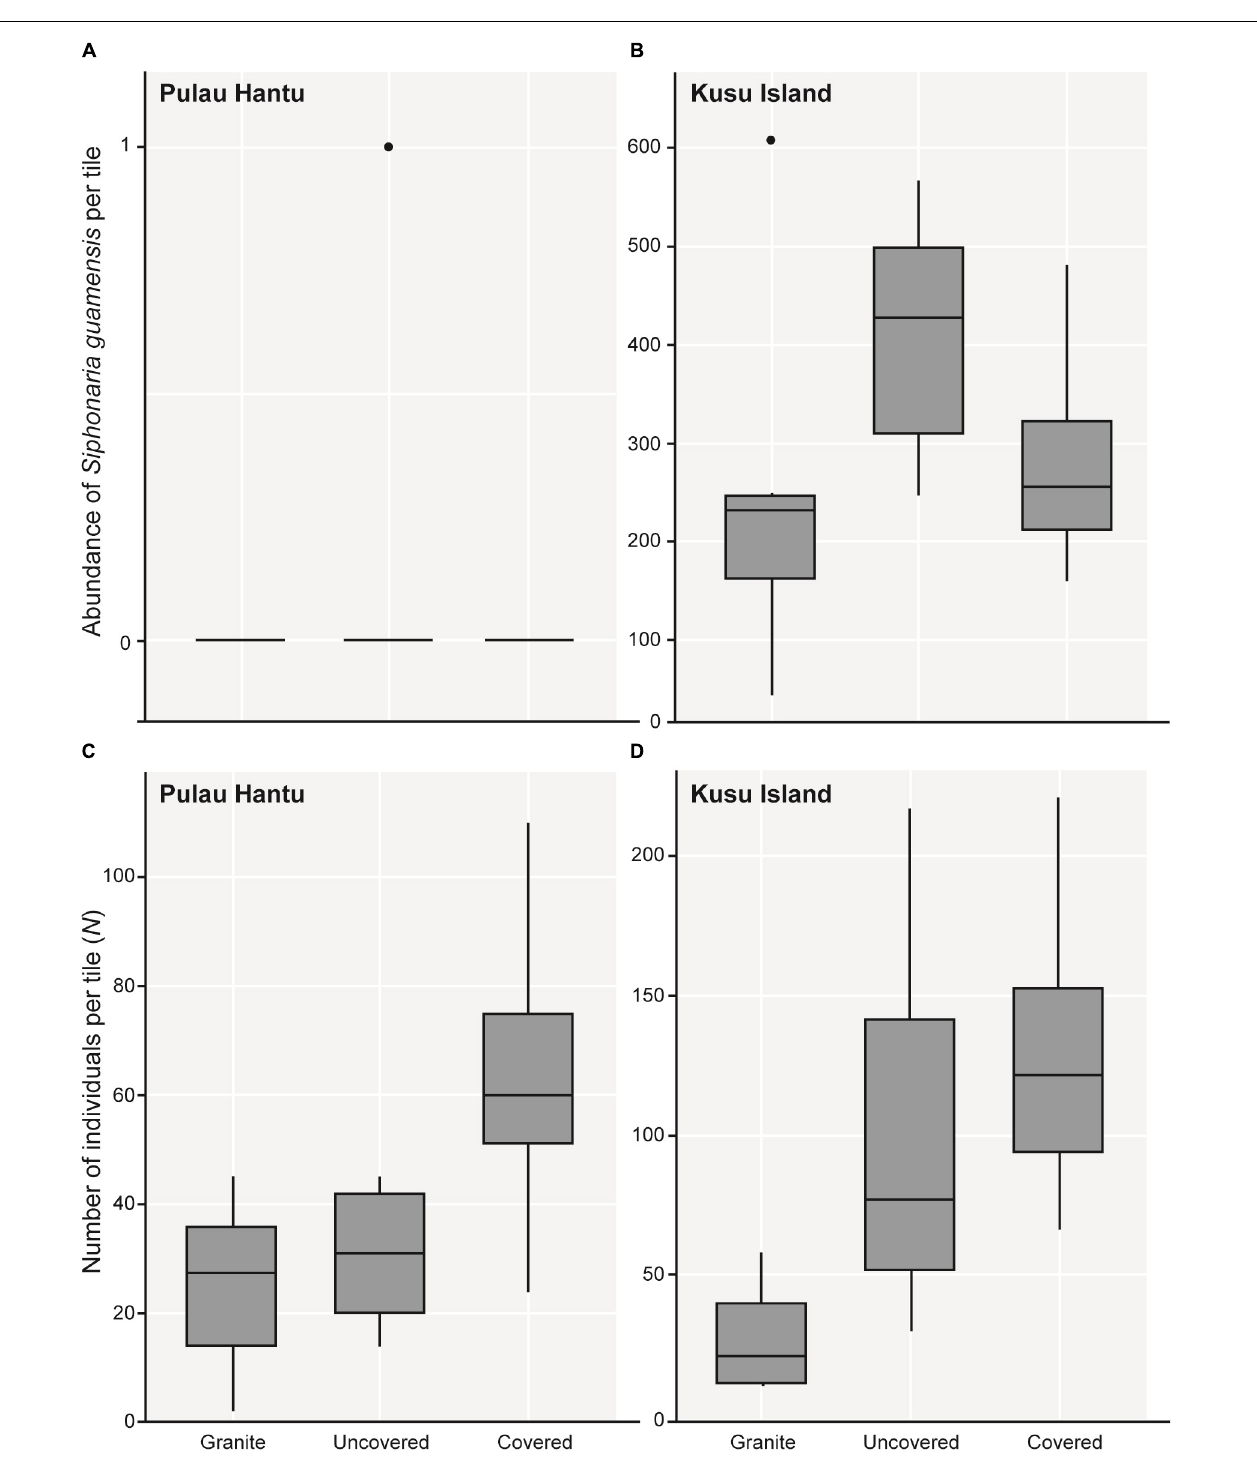
FIGURE 3 | Boxplots showing 5 and 95% confidence intervals (whiskers), 25 and 75% confidence intervals (boxes), and median of the total abundance of (A) Siphonaria guamensis in each tile treatment at Pulau Hantu and (B) Kusu Island; (C) the total number of individuals ( N ) of all 51 species in each tile treatment at Pulau Hantu and (D) Kusu Island after removing S. guamensis